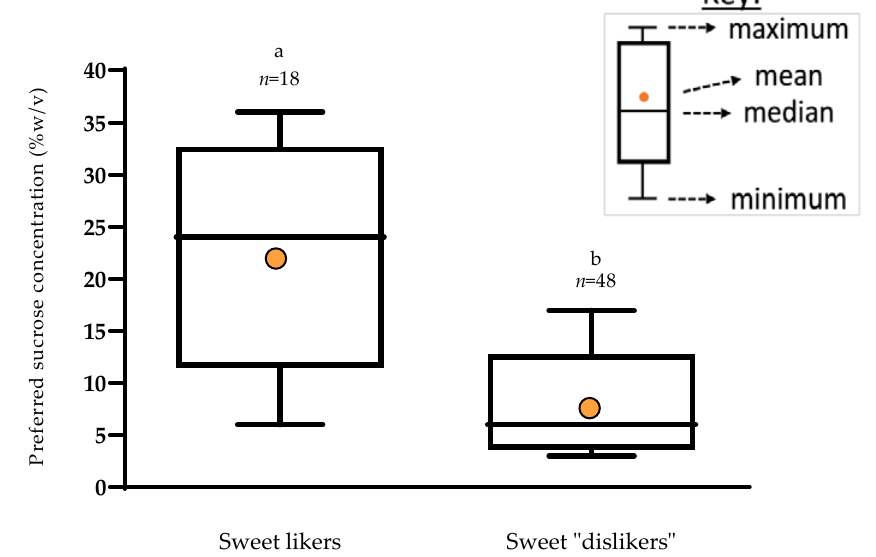
Figure 1. Boxplot showing preferred sucrose concentration (% w / v ) by sweet-liker phenotype status ( n = 66).